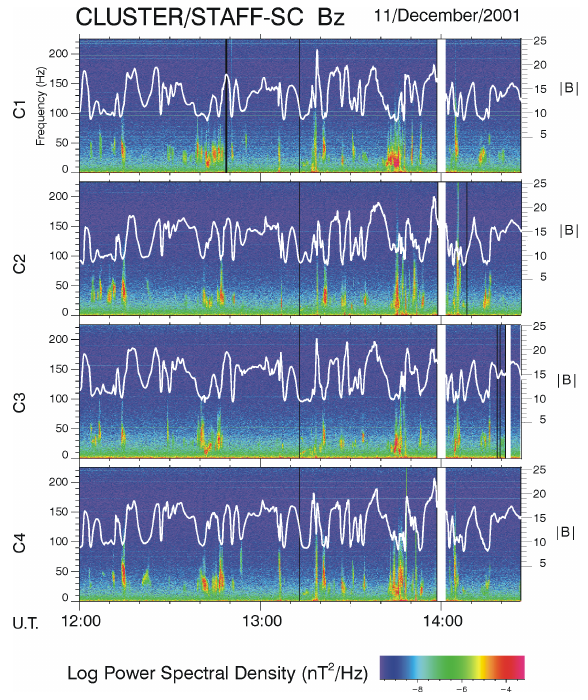
Fig. 1. Spectrograms of whistler emissions in the distant magneto- sphere. The white curves depict the magnetic field strength.